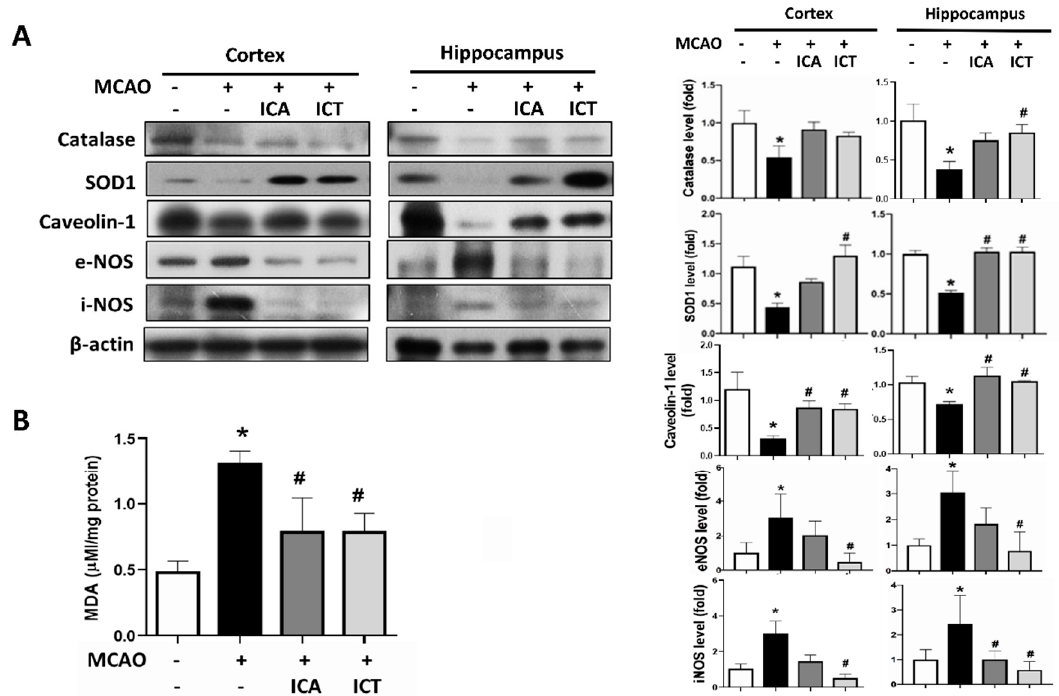
Figure 5. Both ICA and ICT treatment decreased oxidative/nitrosative stress and lipid peroxidation in the left cerebral hemisphere tissues of mice with acute cerebral ischemia–reperfusion. ( A ) The levels of protein expression for antioxidant enzymes (catalase and SOD1) and nitrosative stress-related proteins (caveolin-1, eNOS, and iNOS) in the hippocampus and cortex tissues were determined by Western blot. The quantification of protein expression was determined by densitometry. ( B ) The measurement of brain lipid peroxidation product MDA is shown. Data are presented as mean ± SD ( n ≥ 4). * p < 0.05 compared to sham group; # p < 0.05 compared to MCAO group.